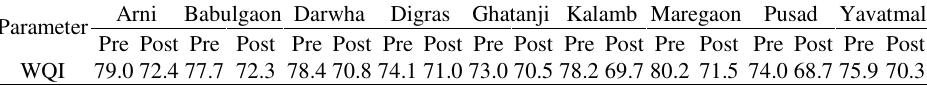
Table 3. Water quality index in Yavatmal district